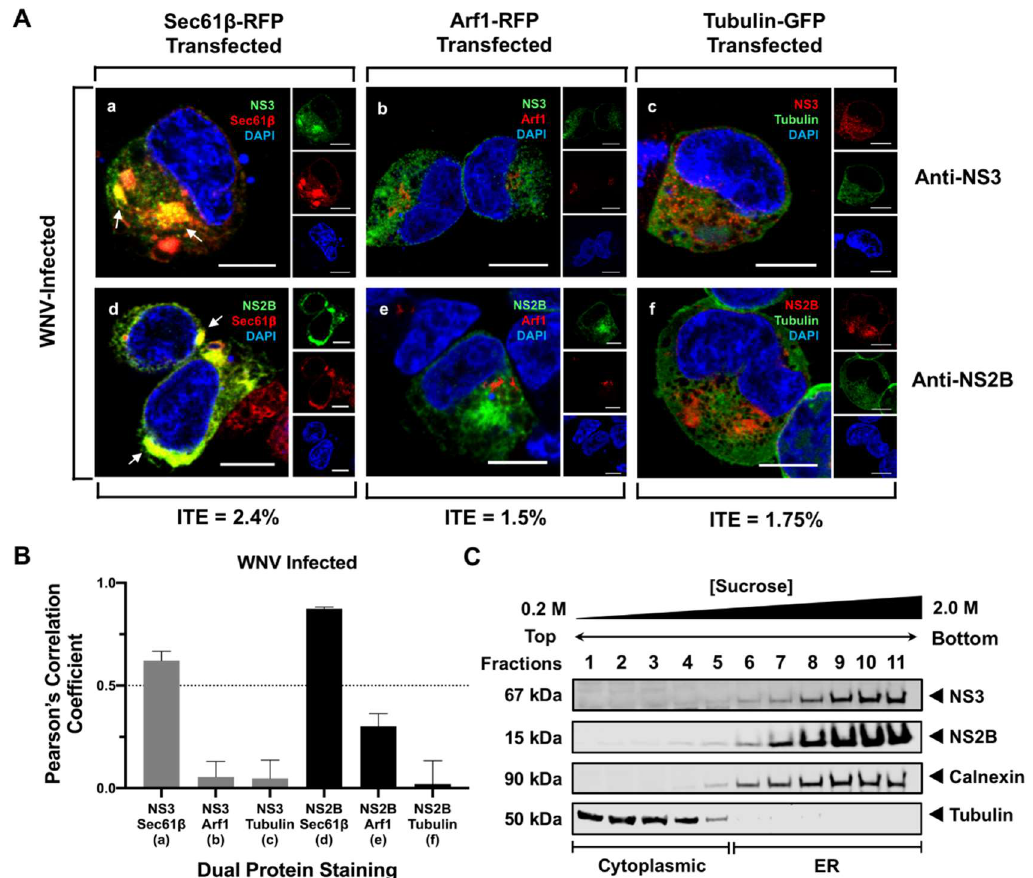
Figure 1. West Nile virus (WNV) nonstructural protein 3 (NS3) and NS2B associate with the ER during infection. ( A ) HEK293T cells were infected with WNV NY99 at a multiplicity of infection (MOI) of 1 and after 1 h, transfected with Sec61β-RFP, ER marker, (red; a , d ), Arf1-RFP, a Golgi marker, (red; b , e ), or tubulin-GFP, a cytoskeletal marker, (green; c , f ). Cells were fixed at 24 h after infection and immunostained with an anti-WNV NS3 antibody (green; a , b , red; c ) or with an anti-WNV NS2B antibody (green; d , e , red; f ). Nuclear DNA was stained with 4,6-diamidino-2-phenylindole (DAPI). Slides were analyzed by confocal laser scanning microscopy. Confocal microscopy images were of optical slice thickness ~1 μm. Scale bar, 10 μm. The main panels represent merged images from three separate channels that are individually shown on the side panels. White arrows indicate colocalization between the green and red channels. The infection–transfection efficiency (ITE) indicating the percentage of cells that were both WNV-infected and transfected for each treatment is listed at the bottom of the panel. Images are representative of two independent infection experiments. ( B ) Pearson’s correlation coefficient (PCC) analysis of the colocalization between NS3 (gray bars) or NS2B (black bars) with cellular markers in WNV infected cells conducted using Coloc 2 (FIJI). PCC values greater than 0.5 (dotted line) indicate a high level of colocalization. Letters in parenthesis beneath each pair of markers correspond to its representative confocal image in Figure 1A. Error bars indicate mean ± standard error of the mean (SEM); n = 5–10 cells per group. ( C ) Cells were infected with WNV NY99 at a MOI of 1 and harvested after 48 h. Cell fractions were separated using sucrose gradient ultracentrifugation and subjected to SDS-PAGE before immunoblotting. The viral proteins were detected using anti-WNV NS3 and NS2B antibodies. The cytoplasmic and endoplasmic reticulum (ER) fractions were observed using antibodies against tubulin and calnexin, respectively.